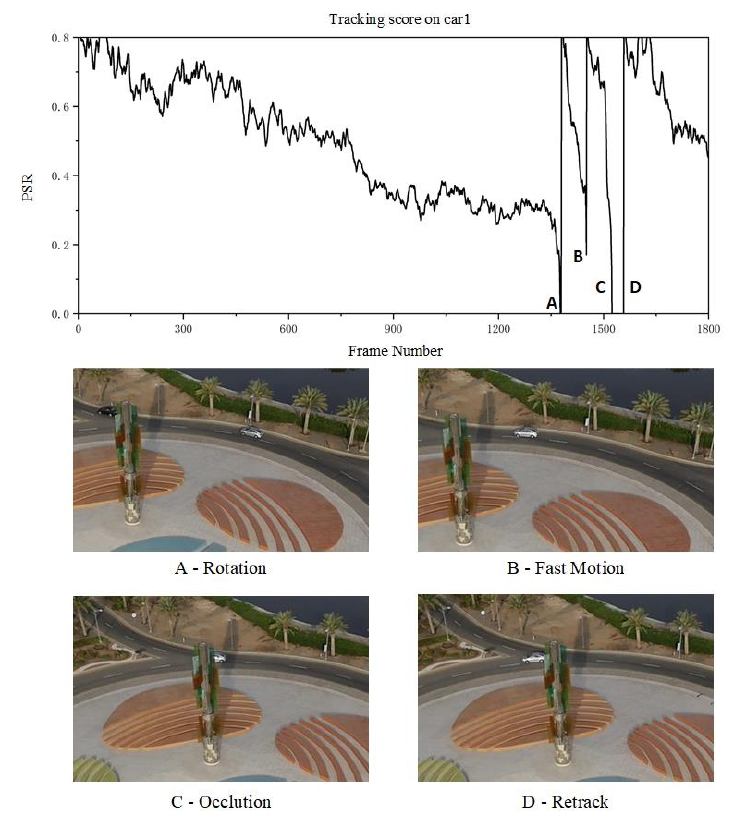
Figure 7. Peak to sidelobe ratio (PSR) during tracking process with tracker Tdarknet. This figure shows that the most challenging section of a video can lead to a decrease in PSR.